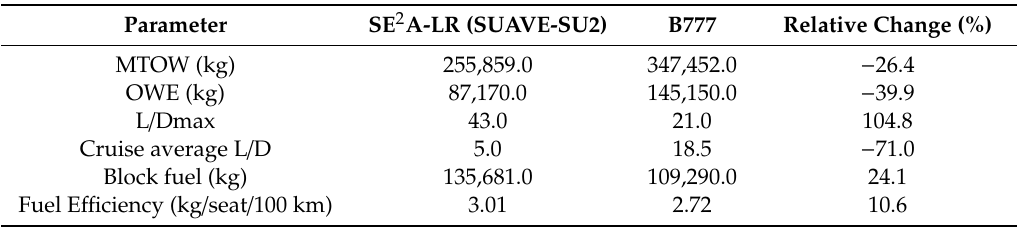
Table 7. Comparison of key aircraft parameters of reference long range aircraft SE 2 A-LR and B777 using high-fidelity analysis.